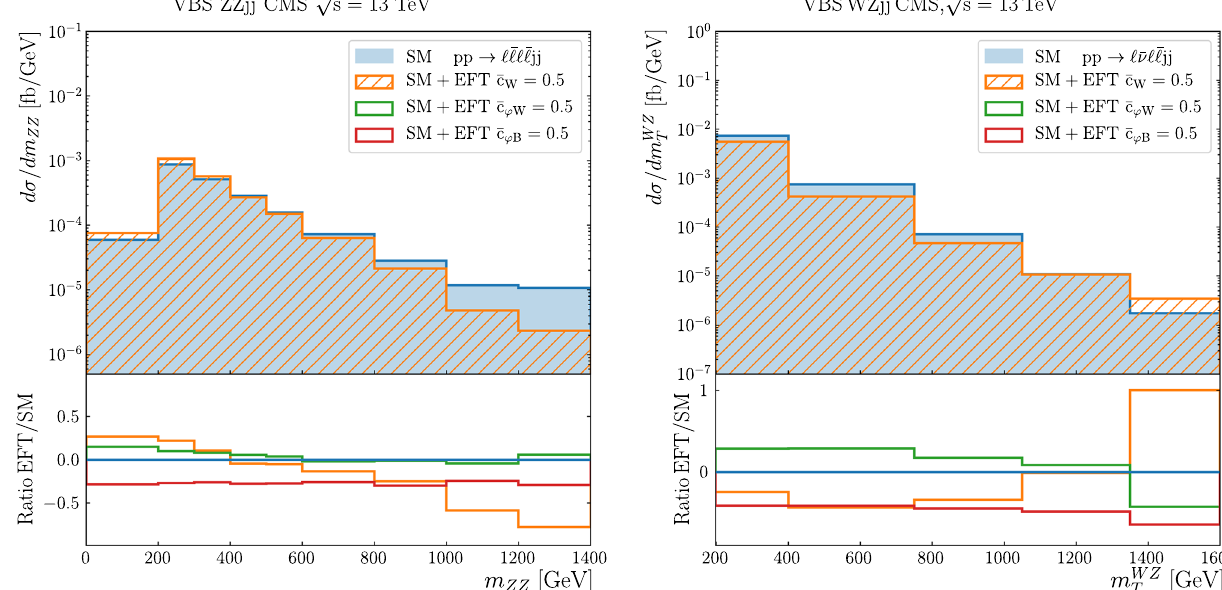
Fig. 14 The m ZZ and m WZ